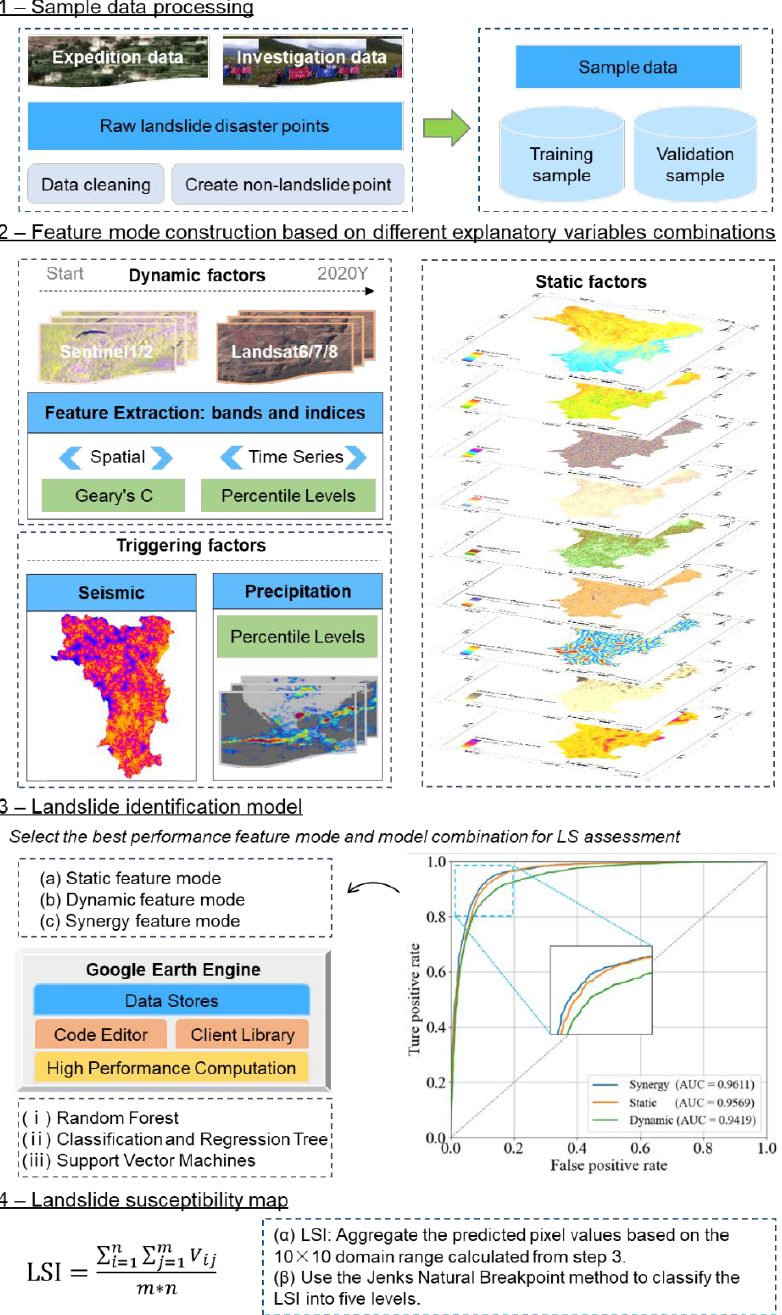
Figure 3. Schematic overview of LS evaluation framework. Specific processing steps for each part (1 – 4) are listed in a dashed box. All explanatory factors are listed in Table A1.